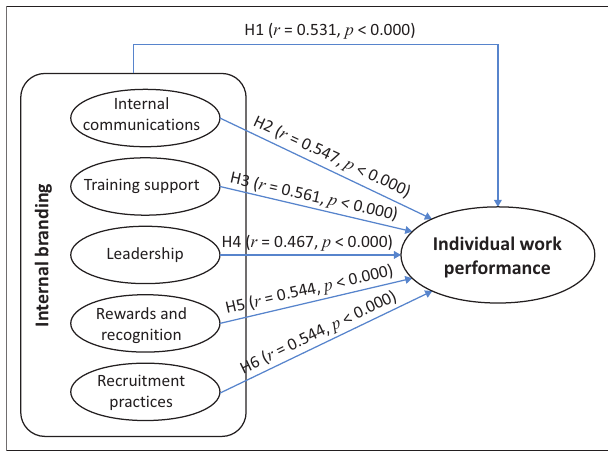
FIGURE 4: Confirmed conceptual